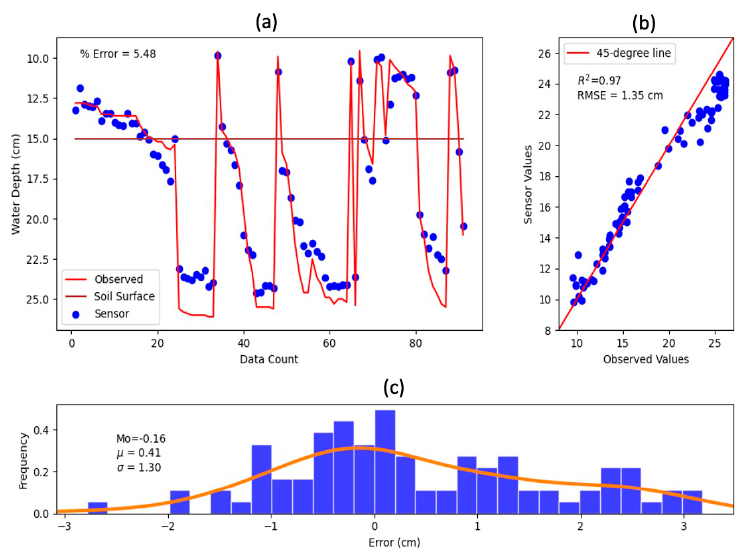
Figure 10. Pseudo-field-based performance test of Sensor 3 showing ( a ) observed and sensor’s water level measurements, ( b ) comparison of observed and sensor values, and ( c ) error (observed-sensor) distribution with Gaussian KDF fit.